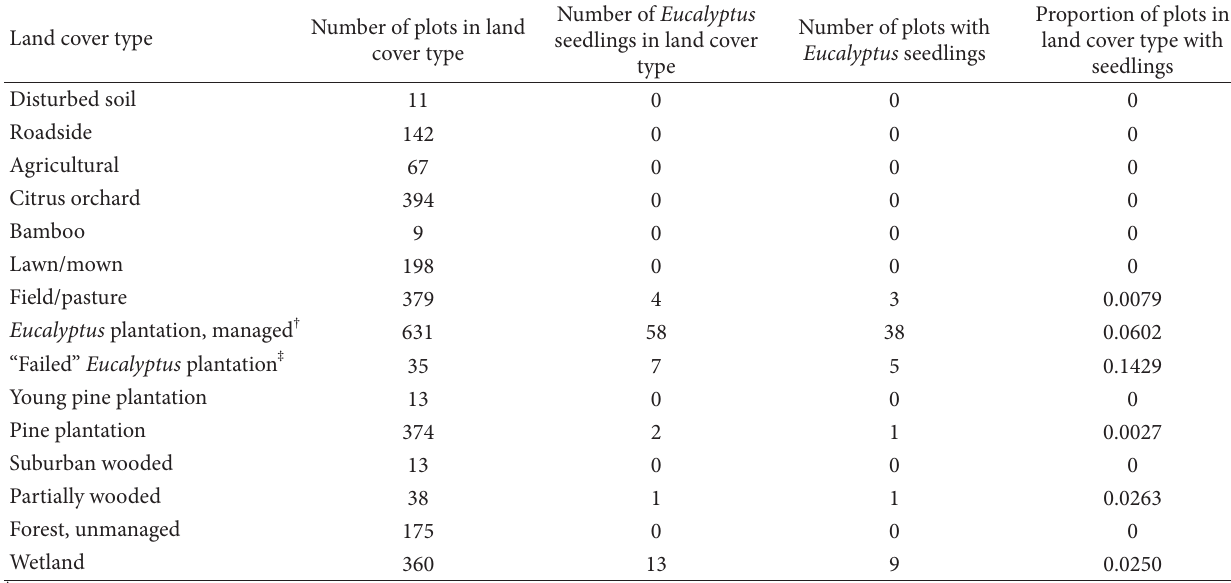
T 2: A summary of the land cover types at each of the plots sampled from all sites surveyed, and the distribution of Eucalyptus seedlings among the land cover types.